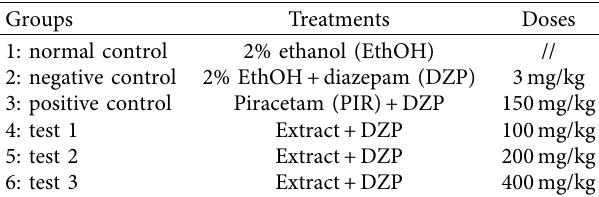
Table 1: Categorization of mice and dosage of drugs in each group. Groups